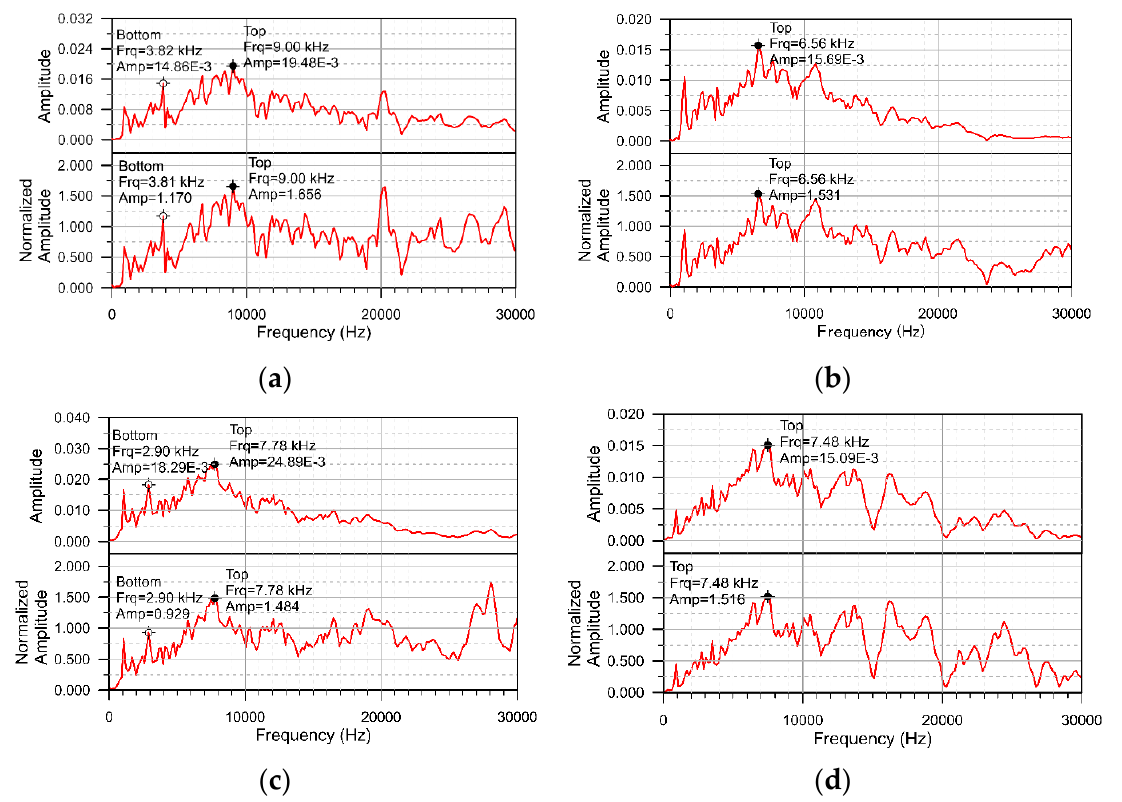
Figure 8. Representative displacement waveform and the normalized amplitude spectra for ( a ) good adhesion; ( b ) C10; ( c )C20; ( d ) C30.